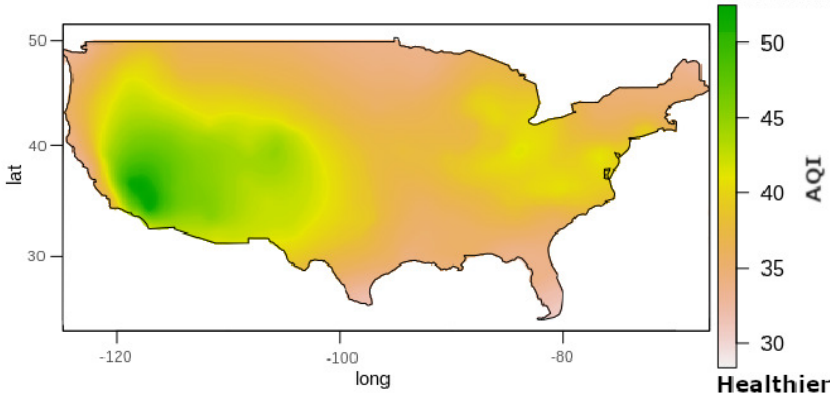
Figure 11. Kriging method interpolation applied to O 3 AQI in the United States